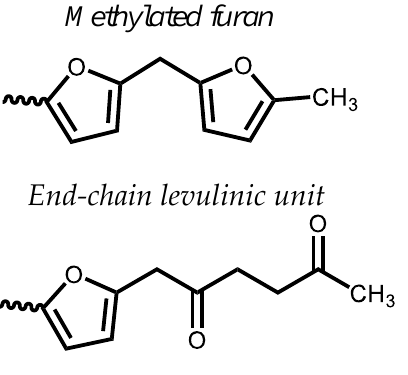
Scheme 1. Methyl groups found in PFA resins.